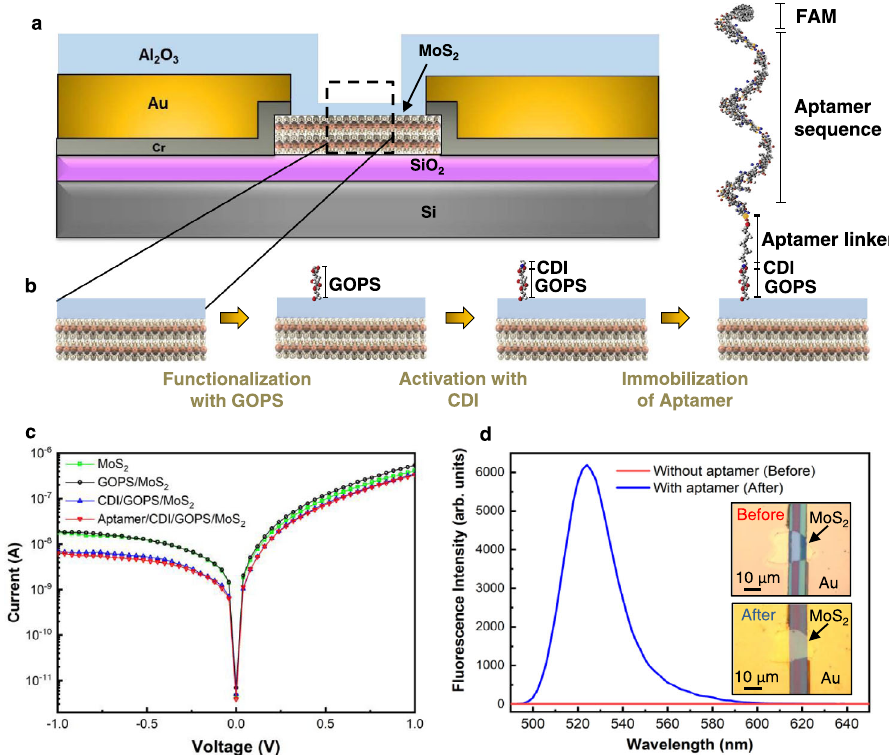
c I – V curves of the sensor during different stages of the functionalization process. d Fluorescence measurement used to con fi rm that the aptamers, labeled with a fl uorescent dye (FAM dye), were immobilized on the sensor surface. The insets show the micrographs of device sensing area before and after